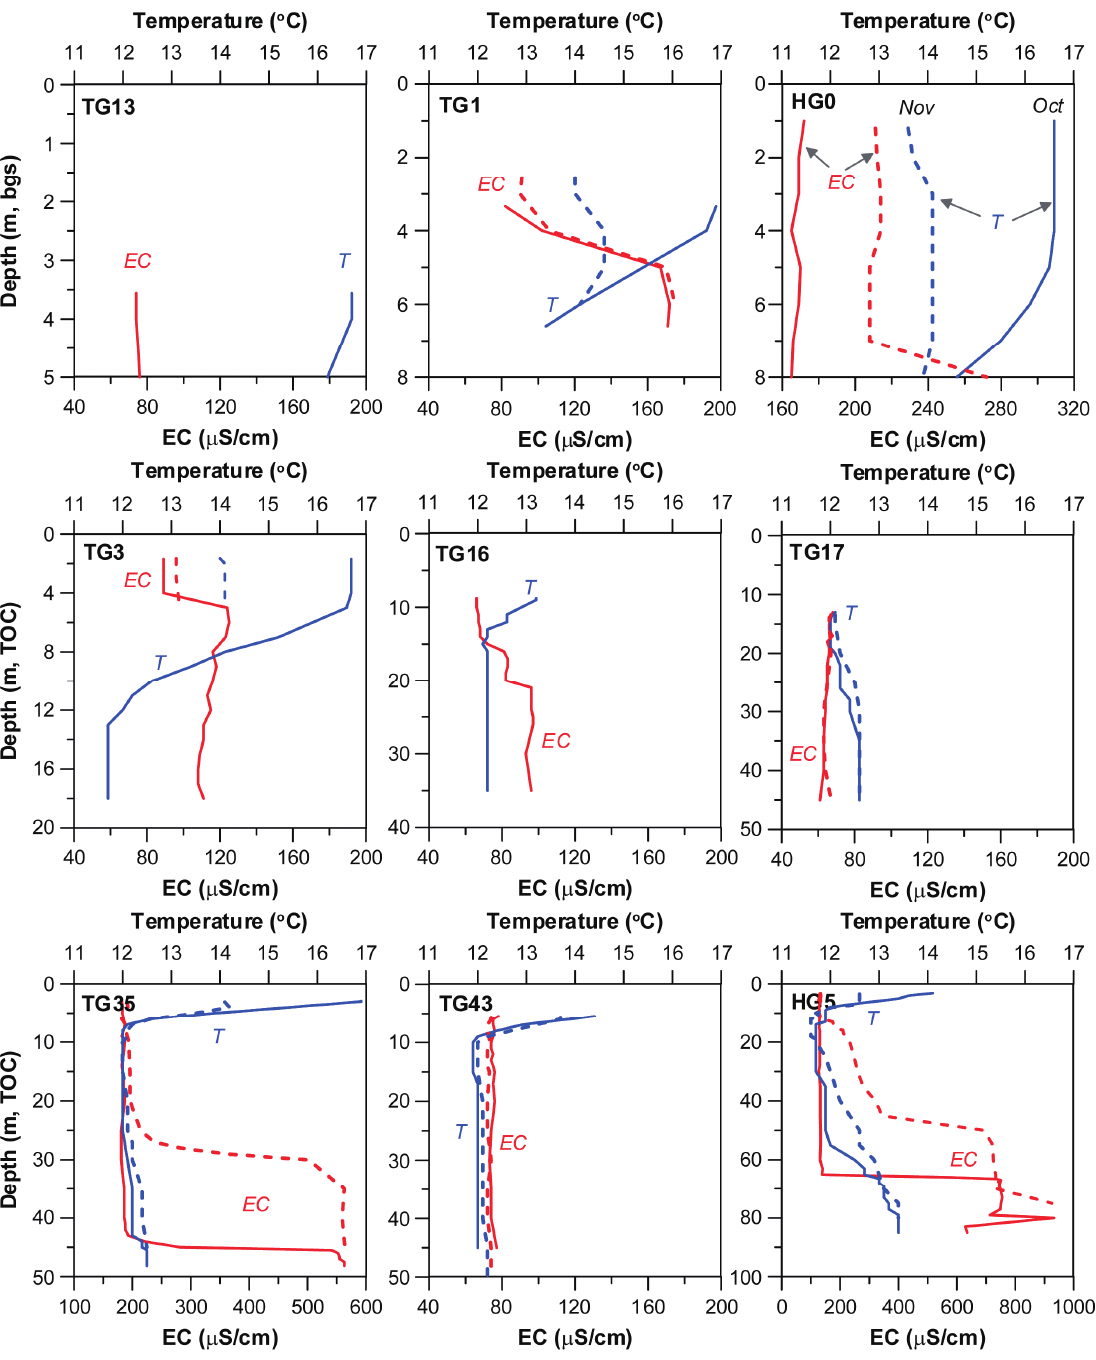
Figure 4. Vertical distribution of groundwater temperature and electrical conductivity (EC) values measured at selected wells on 8 October (solid line) and 20 November (dashed line),